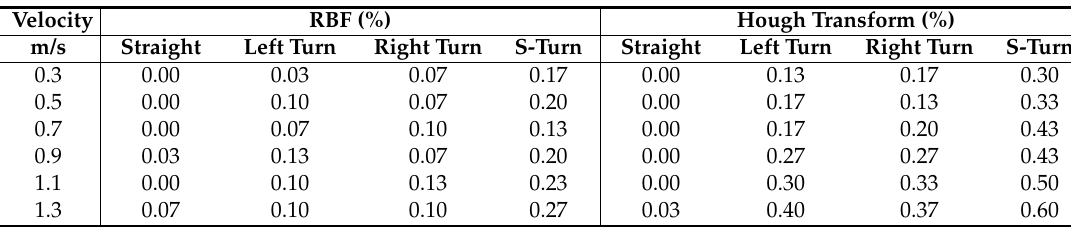
Table 1. Test comparison of indoor path planning method.